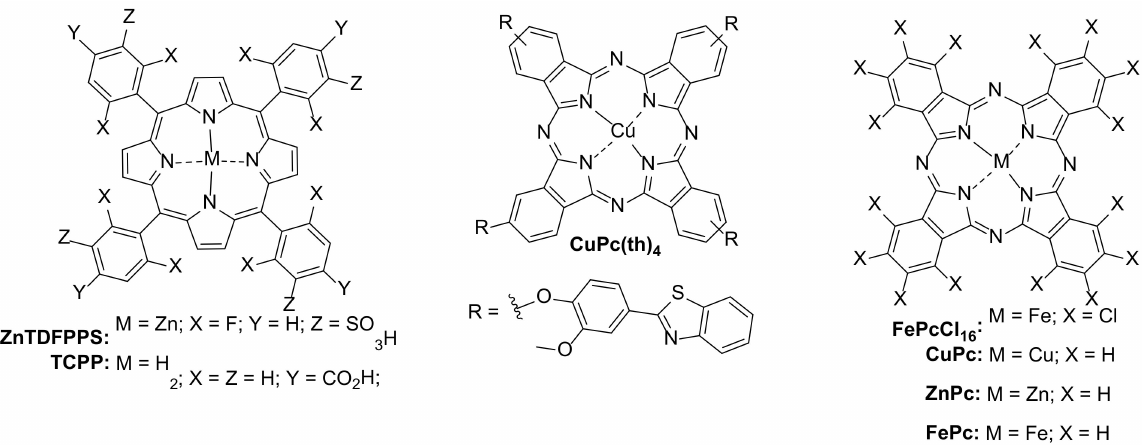
Figure 6. Structures of tetrapyrrolic macrocycles (TPM) used as photocatalysts for degradation of